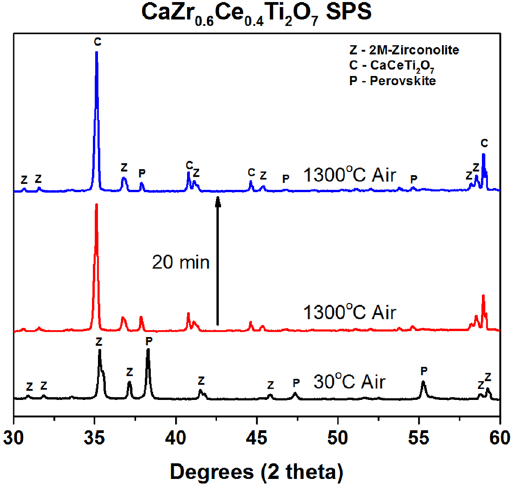
Figure 7. In situ XRD patterns of CaZr 0.6 Ce 0.4 Ti 2 O 7 at 1300 °C showing the conversion of perovskite into CaCeTi